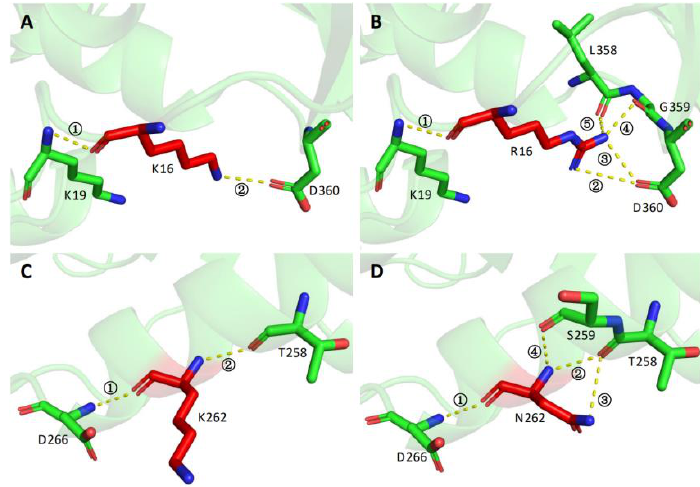
Figure 8. Structural comparison between wild type Xyl21 and the mutants K16R and K262N. ( A ) K16 of Xyl21; ( B ) R16 of mutant K16R; ( C ) K262 of Xyl21; ( D ) N262 of mutant K262N. The yellow dotted lines represent hydrogen bonds, which are labeled with numbers.